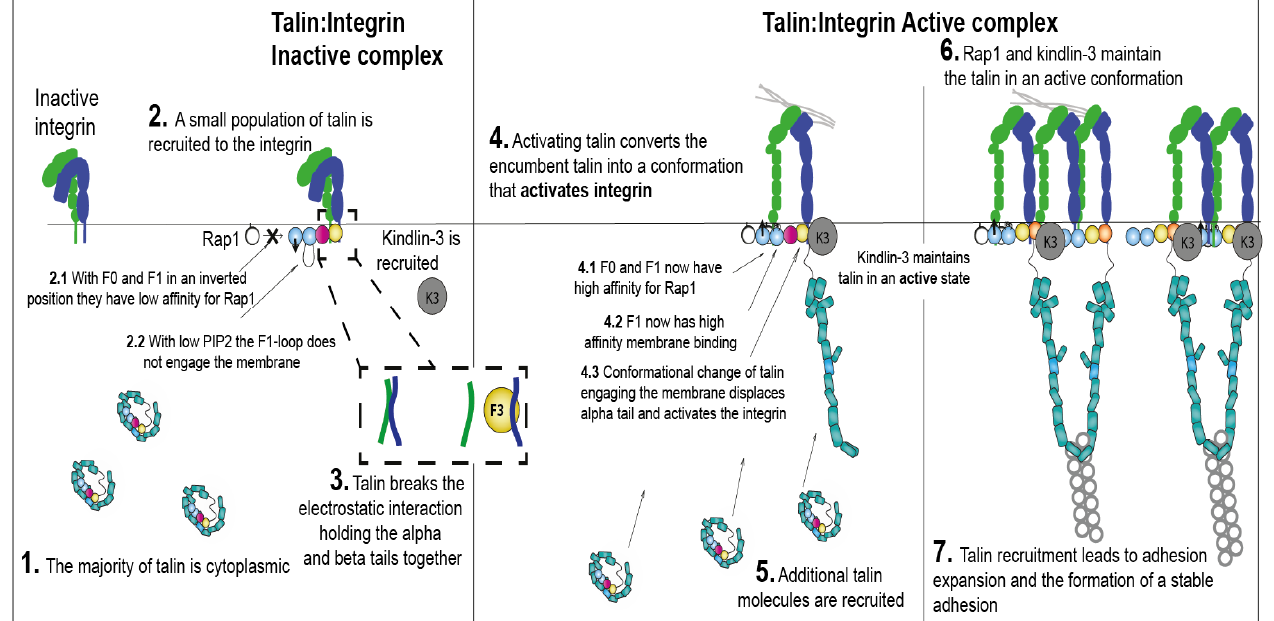
Figure 6. A model of integrin activation by talin-kindlin-Rap1. (1). The majority of talin is in the cell cytoplasm. Integrin adopts a conformation with bent ectodomain and low affinity for ligands. (2). Integrin activation is initiated by a small population of talin being recruited to the integrin. Talin adopts a conformation with inverted F0-F1, in which F0 has low affinity for the membrane-bound Rap1 and F1-loop has low affinity for PIP2. (3). Talin F3 binding to integrin β leads to breaking of the inner membrane clasp. (4). The F0F1 subdomains are inverted, allowing for F0 and F1 to engage Rap1 and PIP2. Displacing the α tail leads to separation of the integrin α and β transmembrane domains and conversion of integrin into the active conformation (extended high affinity). Kindlin-3 cooperates with talin and maintains talin-integrin in an active state. (5). More PIP2 and active Rap1 are generated at the plasma membrane, which recruits additional talin molecules to form the Rap1- talin-integrin-membrane complex. (6). The active integrin conformation is maintained by a complex containing Rap1, talin-1, kindlin-3 and integrins. This complex is linked to the actin cytoskeleton through talin. Kindlin-3 may also contribute to the clustering of integrins at this stage. (7). Talin recruitment and integrin activation engaging ligands leads to more molecule recruitment, resulting in adhesion expansion, strengthening and